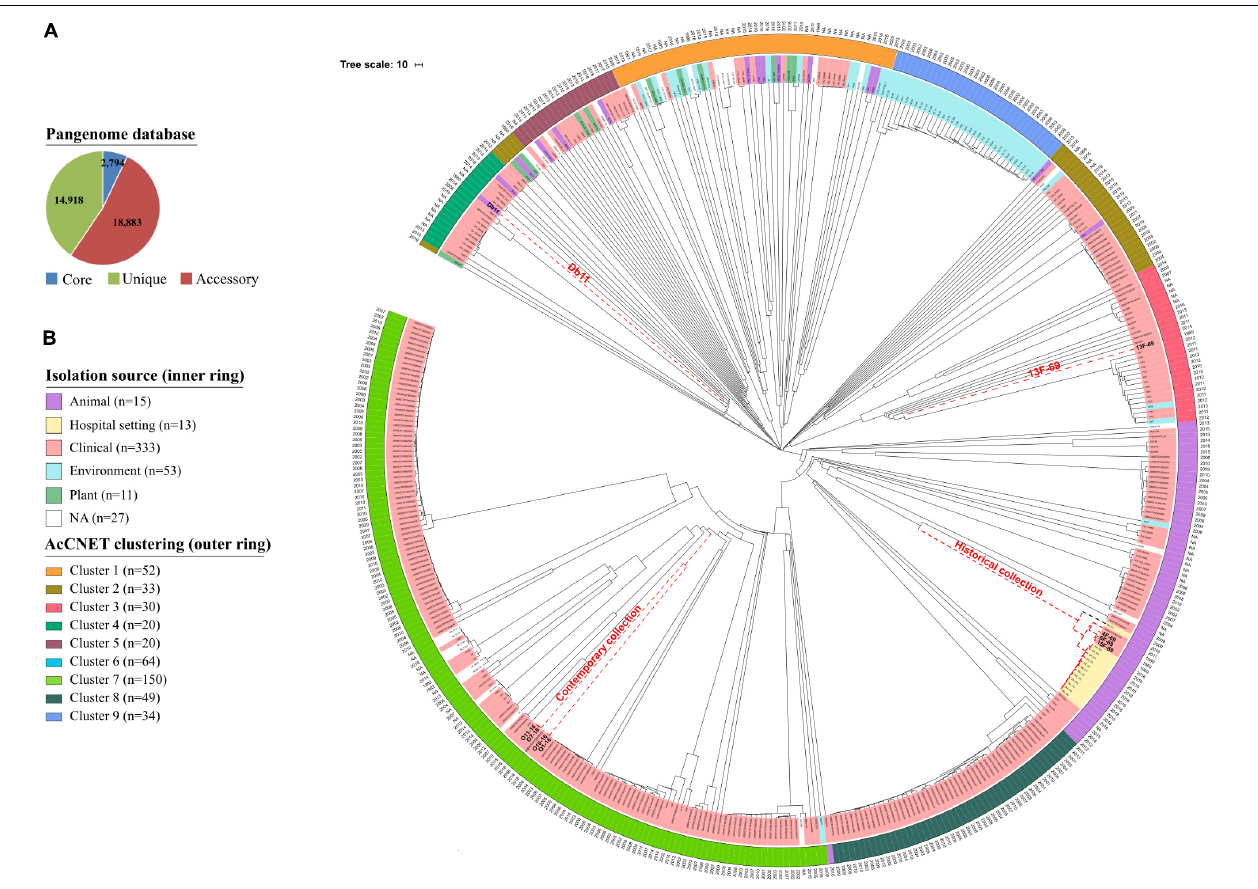
FIGURE 6 | Phylogenetic analysis of 452 Serratia marcescens genomes. (A) Distribution of the total pangenome after core genome multilocus sequence typing (cgMLST) analysis in core (genes present it at least 95% of the isolates; 7.6%), accessory (genes present in > 2 isolates and less than in 95%; 51.6%), and unique genes (genes exclusive of a single isolate; 40.8%). (B) Phylogenetic tree inferred from cgMLST approach, including metadata of source (colors) and year (text). Strains from our collections and the reference genome for S. marcescens species (Db11 strain, assembly accession GCA_000513215.1) are highlighted in red dashed nodes. External circle highlights clusters inferred by AcCNET analysis of accessory